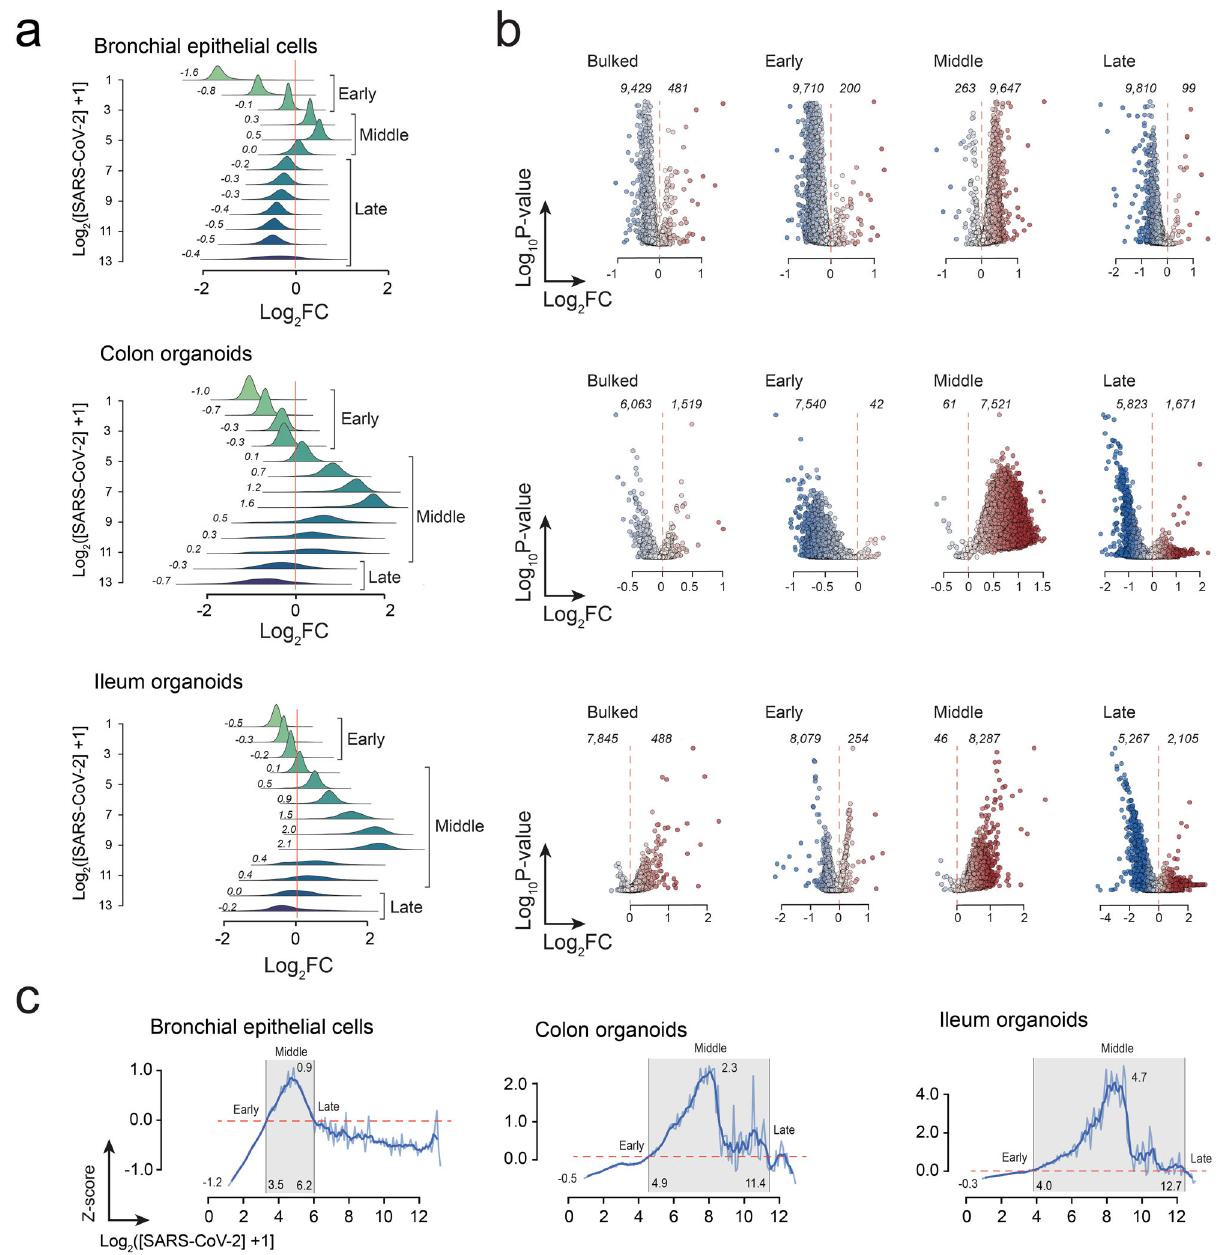
Fig. 1 Global transcriptional response to SARS-CoV-2 in human bronchial epithelial cells, colon- and ileum-organoids. a Distribution of log 2 FC values for all genes plotted against SARS-CoV-2 reads using a log 2 scale. Mean log 2 FC values at each interval are shown to the left of each histogram. b Volcano plot analysis of infected cells with respect to noninfected cells using bulked cells, and subgroups comprising cells at early, middle, and intermediate phases of infection. For clarity, corrected P values were removed from the ordinate axis. c Mean transcriptional response of each cell type. Each plot was calculated from individual gene pro fi les scaled using z -scores with respect to the transcript levels observed in uninfected cells. These plots con fi rm the global oscillatory transcriptional pro fi le of genes at increasing SARS-CoV-2